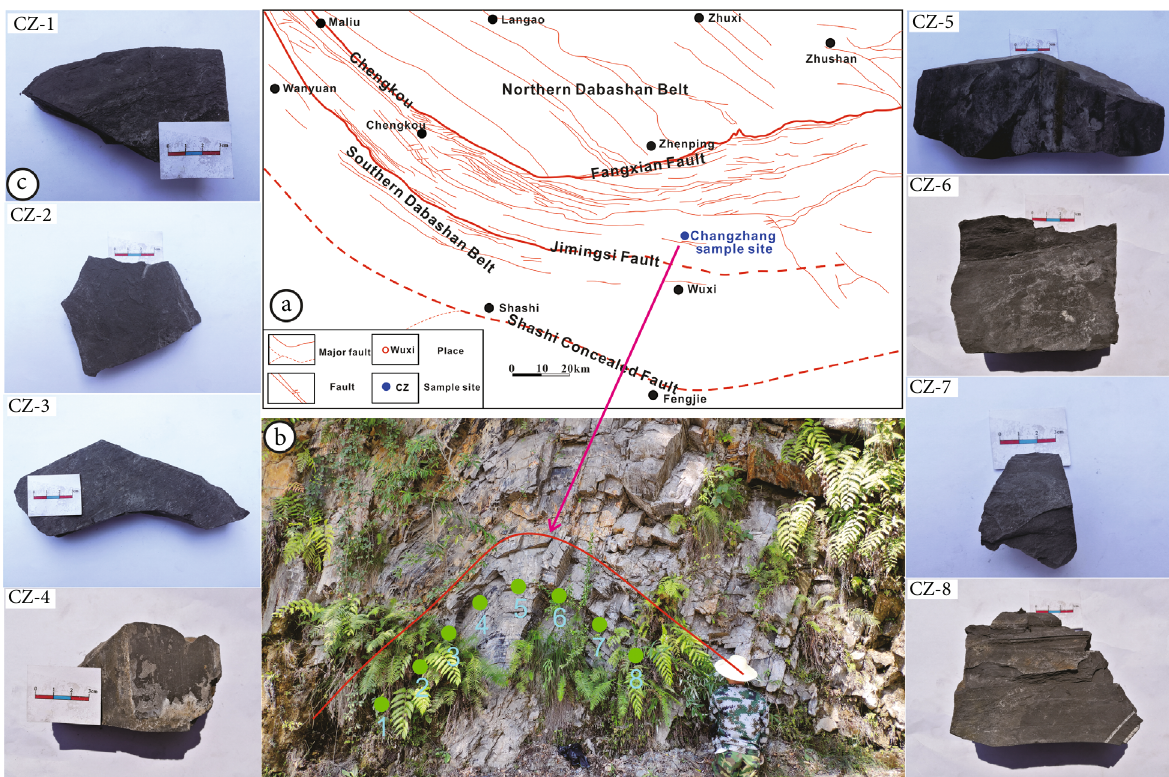
Figure 1: (a) Geographic location and structure of the study region in the northeast Chongqing. (b) Outcrops and the structural deformation characteristics of samples in the Changzhang region. The anticline is well exposed, and the two wings are basically symmetrical, showing good deformation characteristics. (c) Sample information, the samples in anticline core have the strongest deformation. Modi fi ed from Hu et al. [41] and Shi et al.